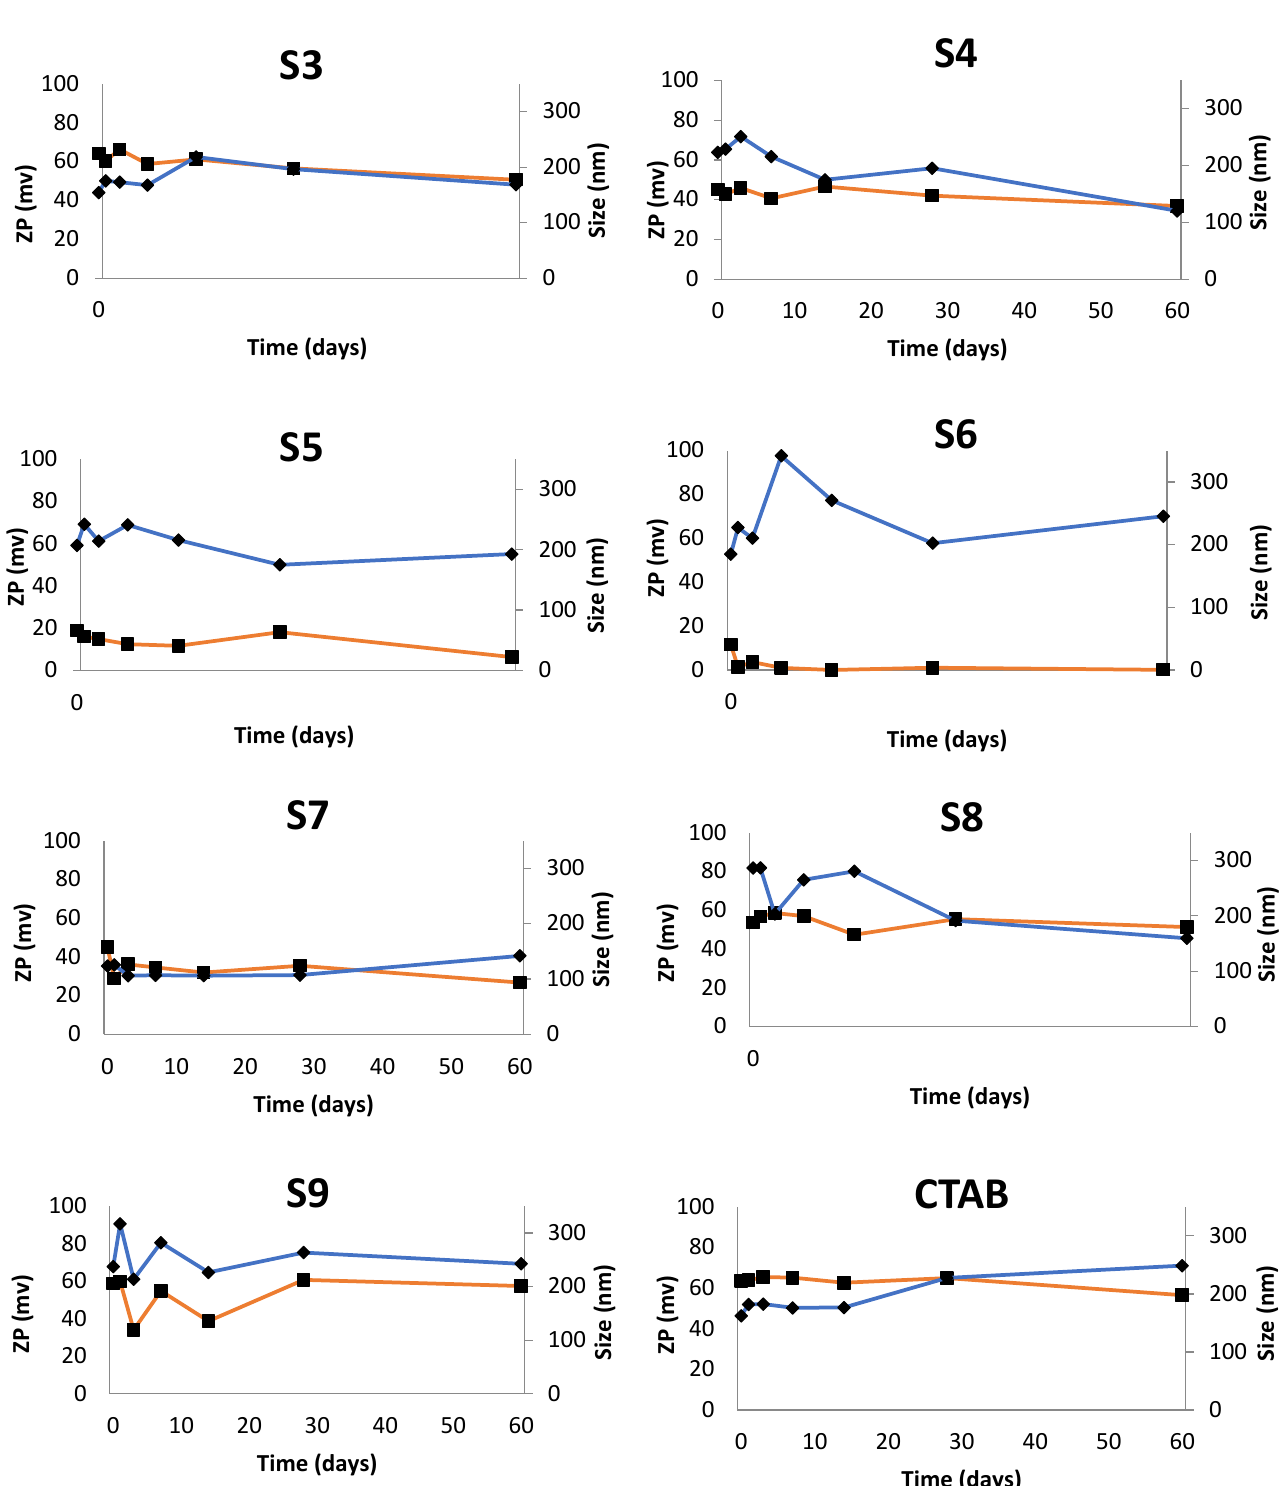
Figure 6. Mean size and zeta potential (ZP) monitored over a period of 60 days of NEs produced with surfactant 1 to 9 (S1 to S9) and with CTAB (used as model surfactant). Blue line represents the mean size and orange line the ZP. The most stable NEs were found to be those obtained with S2 and S7 (Figure 6). These NEs depict similar mean size and ZP profiles during the assay. Huge variations in size and ZP were recorded over time for the remaining surfactant-based NEs. The PI of NEs